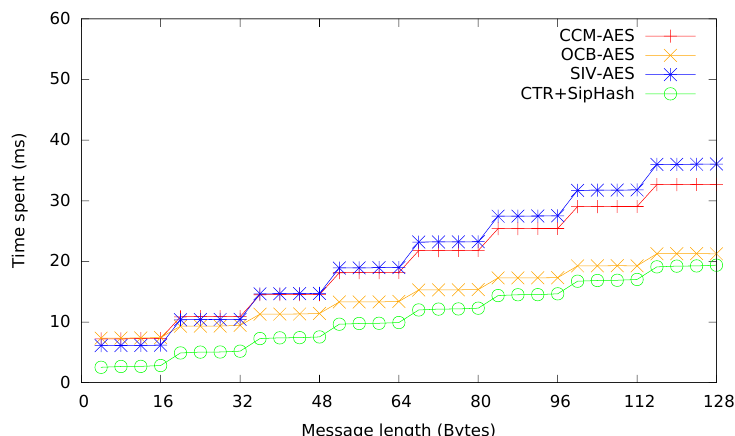
Figure 8. Time required for authenticated encryption with different modes. CCM, counter with cipher block chaining (CBC)-MAC.